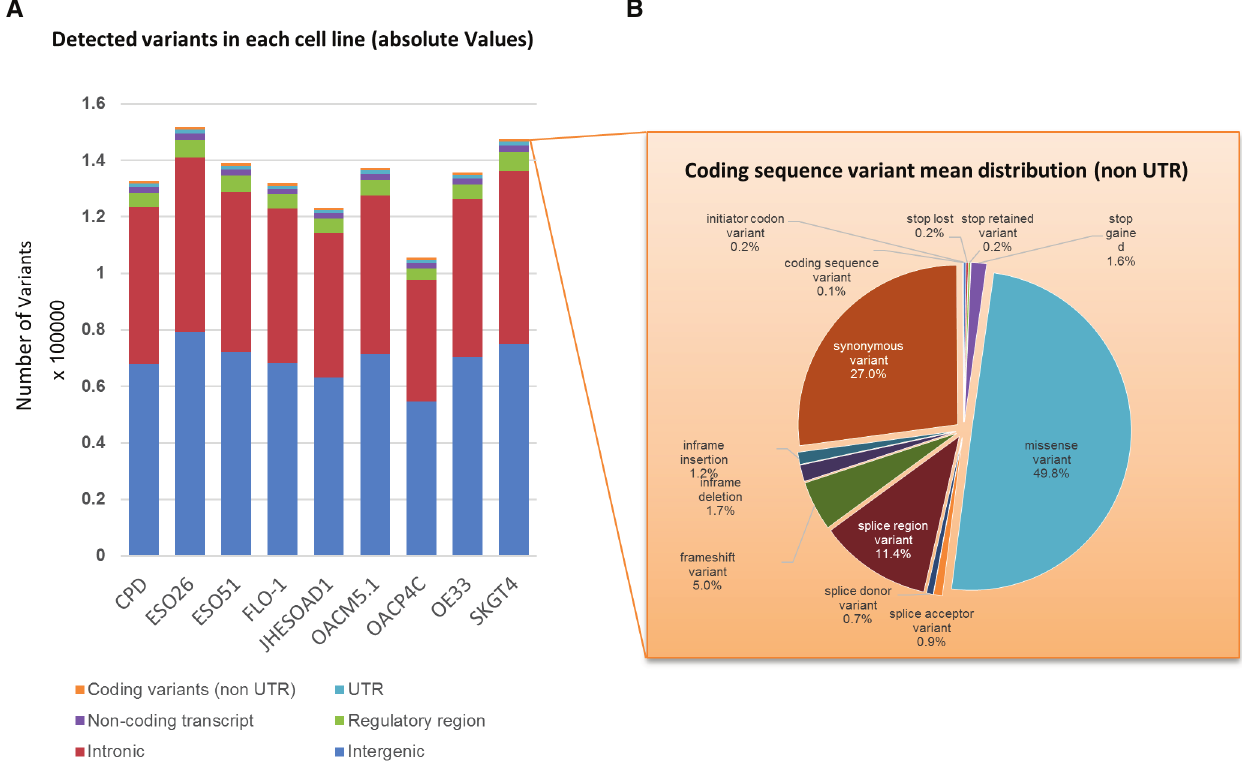
Figure 1. Distribution of detected variants and coding sequence consequences (mean percentage value). A ) Bar chart showing the distribution of called variants across various regions of the genome as indicated; B ) Details of the coding sequence variants identified by the Variant Effect Predictor (Ensembl) expressed as a mean percentage value of all cell lines (values were not statistically different among samples).